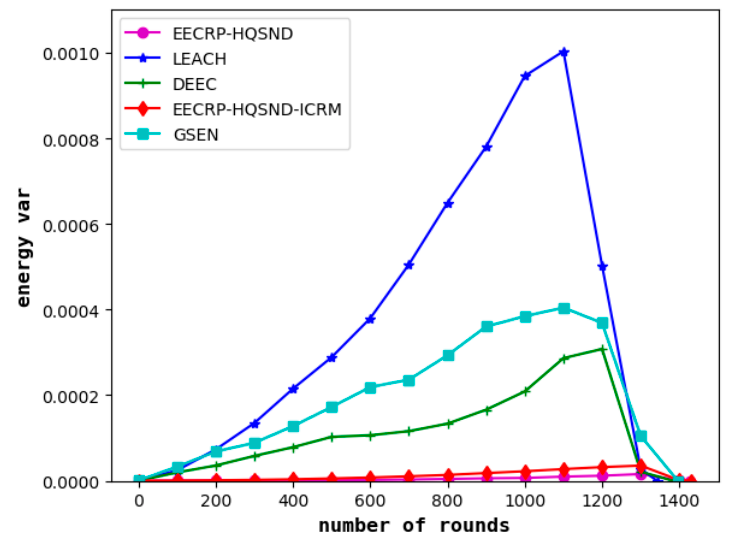
Figure 21. The variance of the residual energy of the nodes in the network.